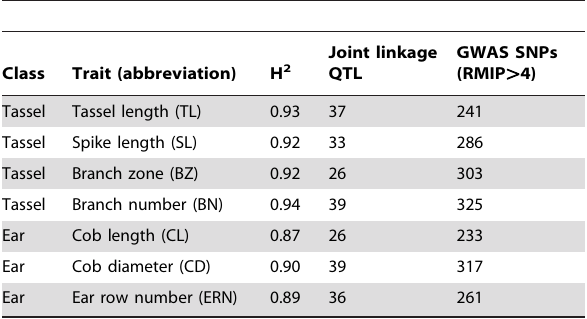
Table 1. Summary of maize inflorescence phenotypes and QTL